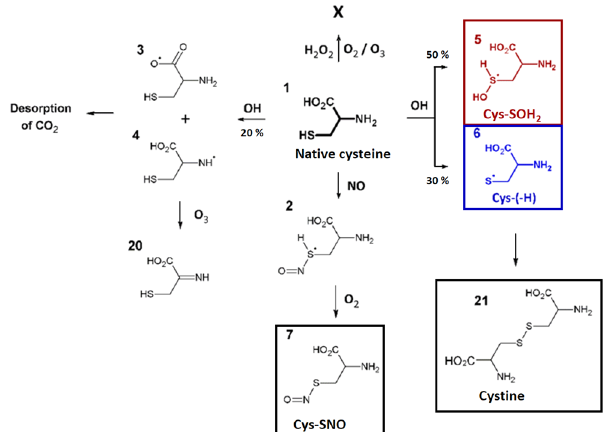
Figure 5. Summary of the predicted reaction paths encountered during the oxidation of native cysteine. A solid black box indicates stable oxidation products. Important intermediates are marked using dashed coloured boxes. As the interaction of cysteine with OH radicals resulted in multiple reaction products, branching ratios are depicted on the figure (based on the total number of reactions